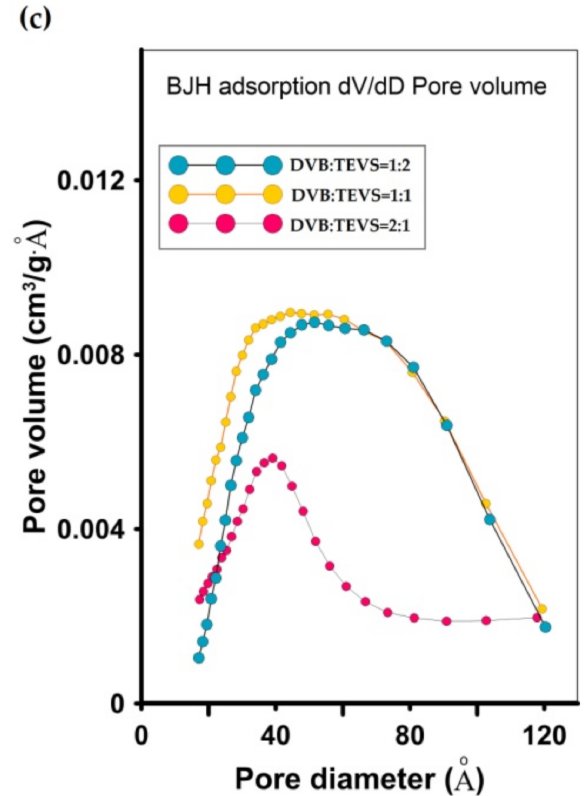
Figure 5. The nitrogen adsorption-desorption isotherms for DVB-TEVS materials ( a ), pore size distributions by the Barrett– Joyner–Halenda (BJH) with Halsey-Faas correction for desorption ( b ) and adsorption data ( c ).